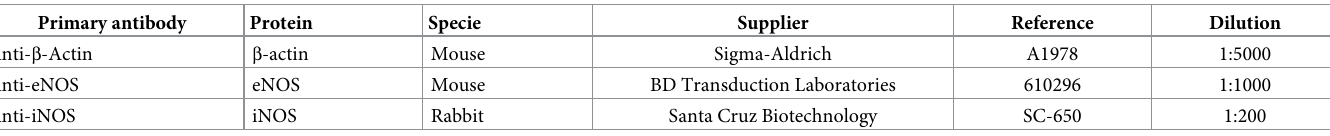
Table 2. Primary antibodies used in this